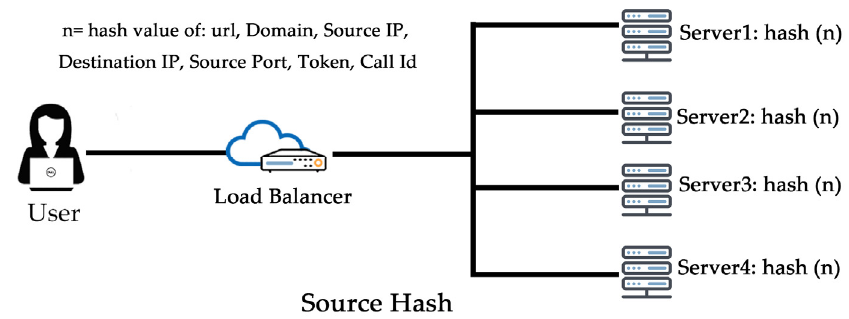
Figure 3. IP hash algorithm.